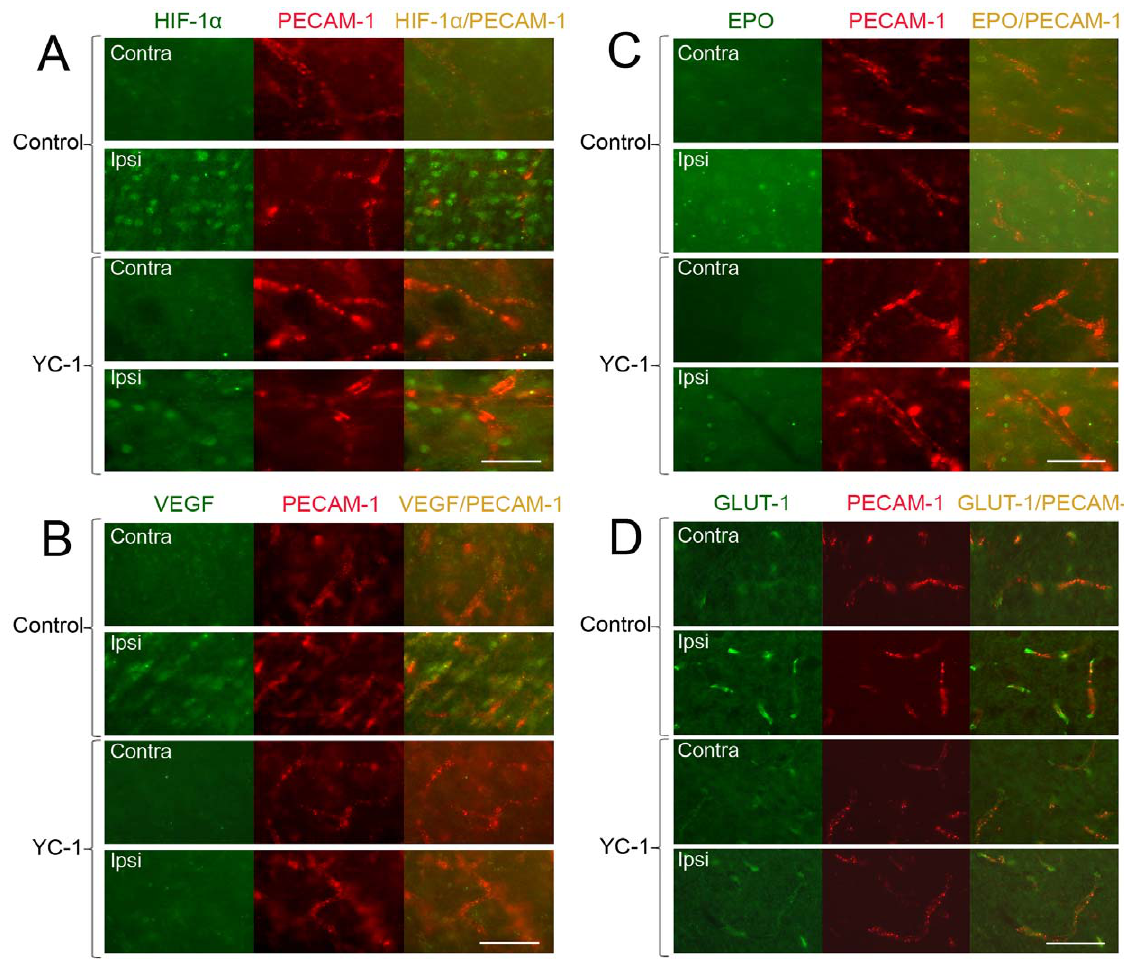
Figure 6. Effect of YC-1 on HIF-1 expression in endothelial cells in ischemic brains. The protein levels of HIF-1 a and its down-stream genes were analyzed by double immunostaining with the endothelial marker PECAM-1 after rats were subjected to 90 min ischemia and 24 hr reperfusion. Rats received YC-1 (2 mg/kg, i.v.) at 24 h and 30 min prior to the onset of ischemia. The brain area of interests was the same as in Figure 4. ( A ) Double immunostaining of HIF-1 a (green) and PECAM-1 (red). ( B ) Double immunostaining of VEGF (green) and PECAM-1 (red). ( C ) Double immunostaining of EPO (green) and PECAM-1 (red). ( D ) Double immunostaining of GLUT-1 (green) and PECAM-1 (red). Scale bar, 50 m m.